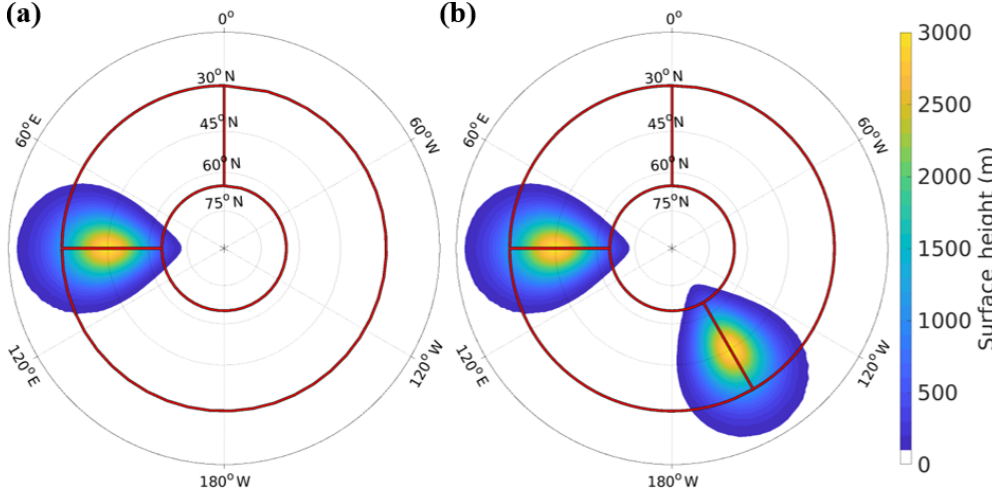
Figure 1. Surface height (shading) of the idealized model integrations with (a) a single 3km high Gaussian mountain centered at 45 ◦ N, 90 ◦ E and (b) two 3km high Gaussian mountains centered at 45 ◦ N, 90 ◦ E and 45 ◦ N, 150 ◦ W, respectively. The red outlines indicate the block genesis regions described in Table